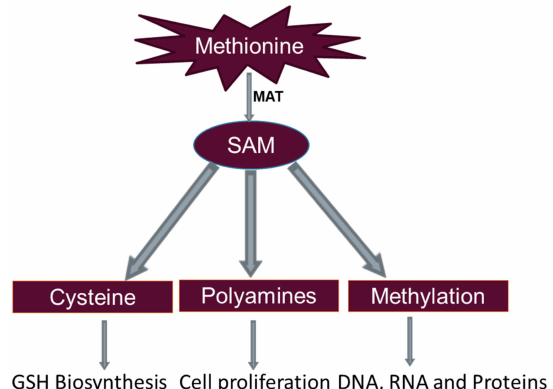
Figure 1. Methionine metabolism and major functions with relevance to GSH biosynthesis, Cell proliferation and methylation. GSH: Glutathione; MAT: Methionine adenosyltransferase; SAM: S-adenosyl